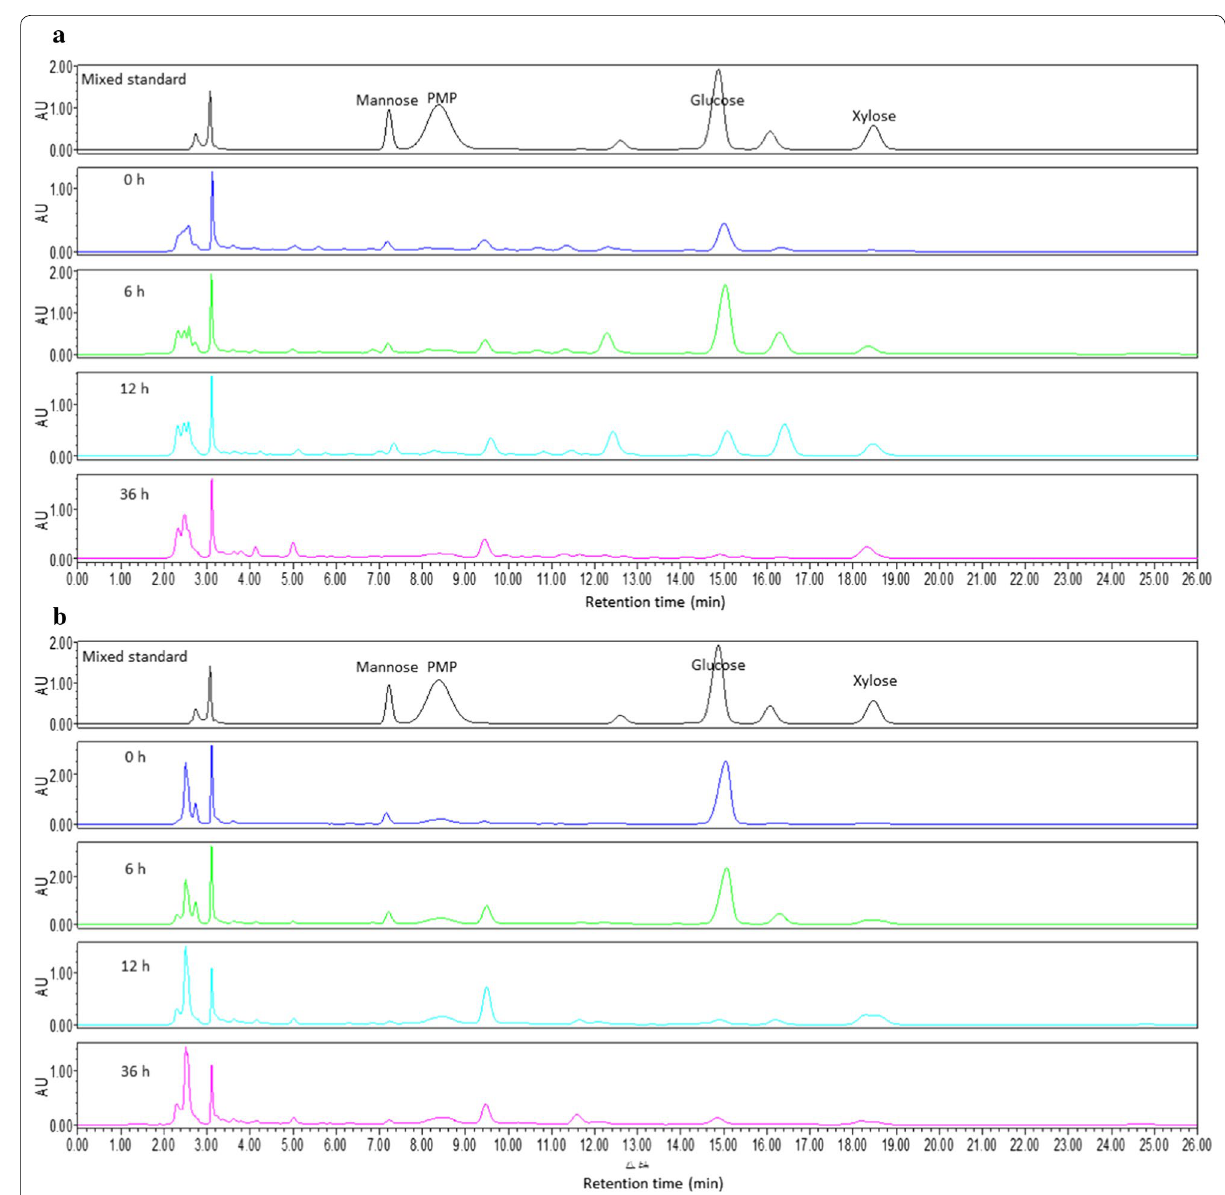
Fig. 5 Chromatogram of CDDGS ( a ) and RDDGS ( b ) at 0 h, 6 h, 12 h and 36 h fermentation time, respectively